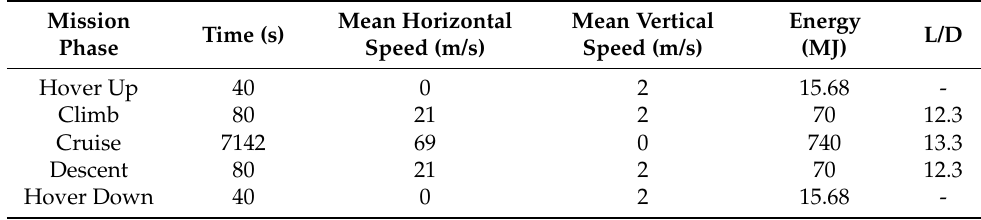
Table 18. Parameter values for each